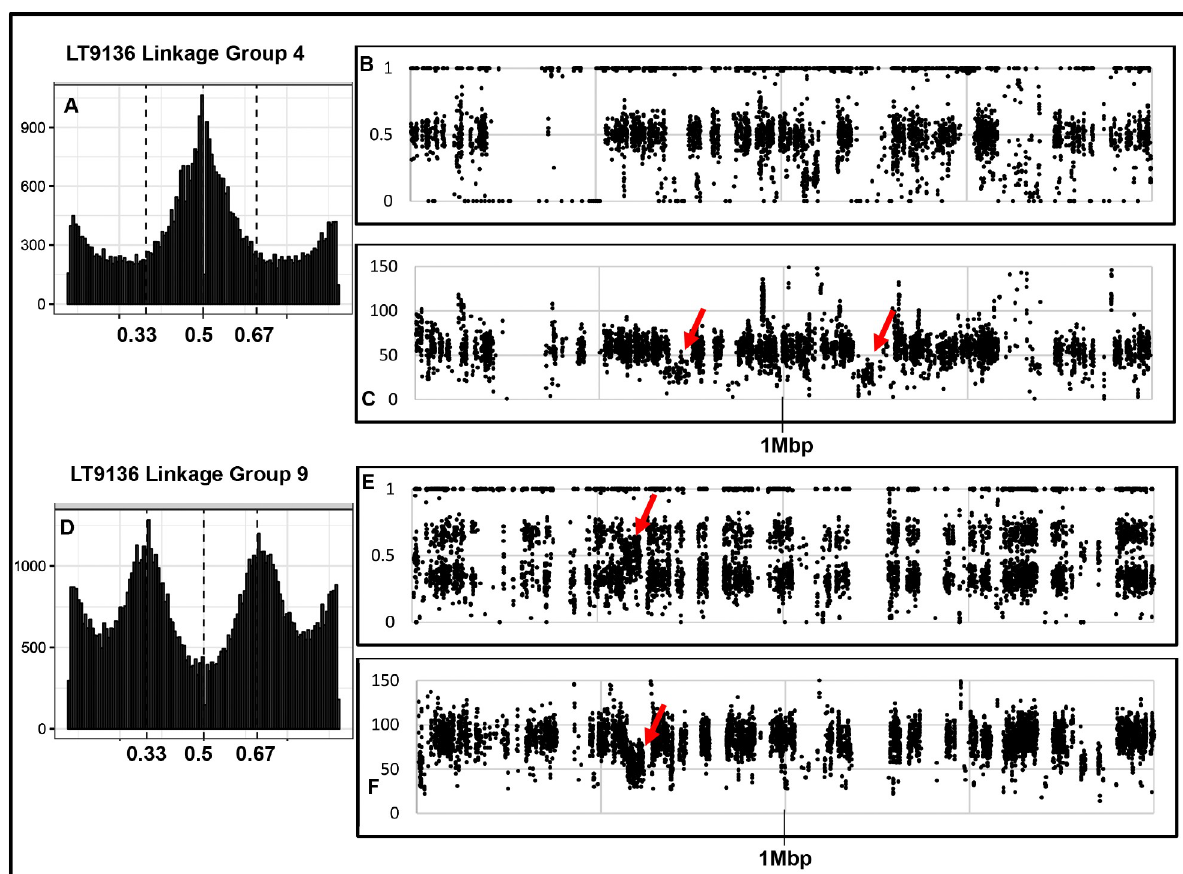
Fig 5. Heterozygous allele frequencies and sequence coverage for Phytophthora capsici isolate LT9136 within linkage groups 4 and 9. Histograms (A, D) plot the major and minor allele frequencies. B and E plot allele frequencies across 2Mbp for each linkage group and C and E plot the sequence depth across the same region. Notice most allele frequencies reflect copy number except the regions indicated by red arrows. In linkage group 4 (diploid), copy number at two sites appear haploid and the allele frequencies are fixed at 0 or 1. In linkage group 9 (triploid) the copy number and allele frequency appear